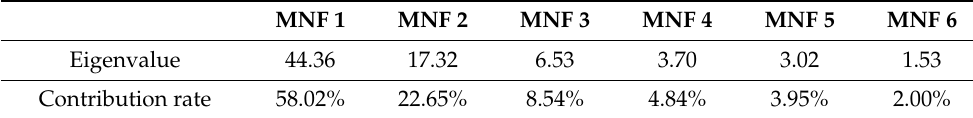
Table 2. The eigenvalues and contribution rates of MNF